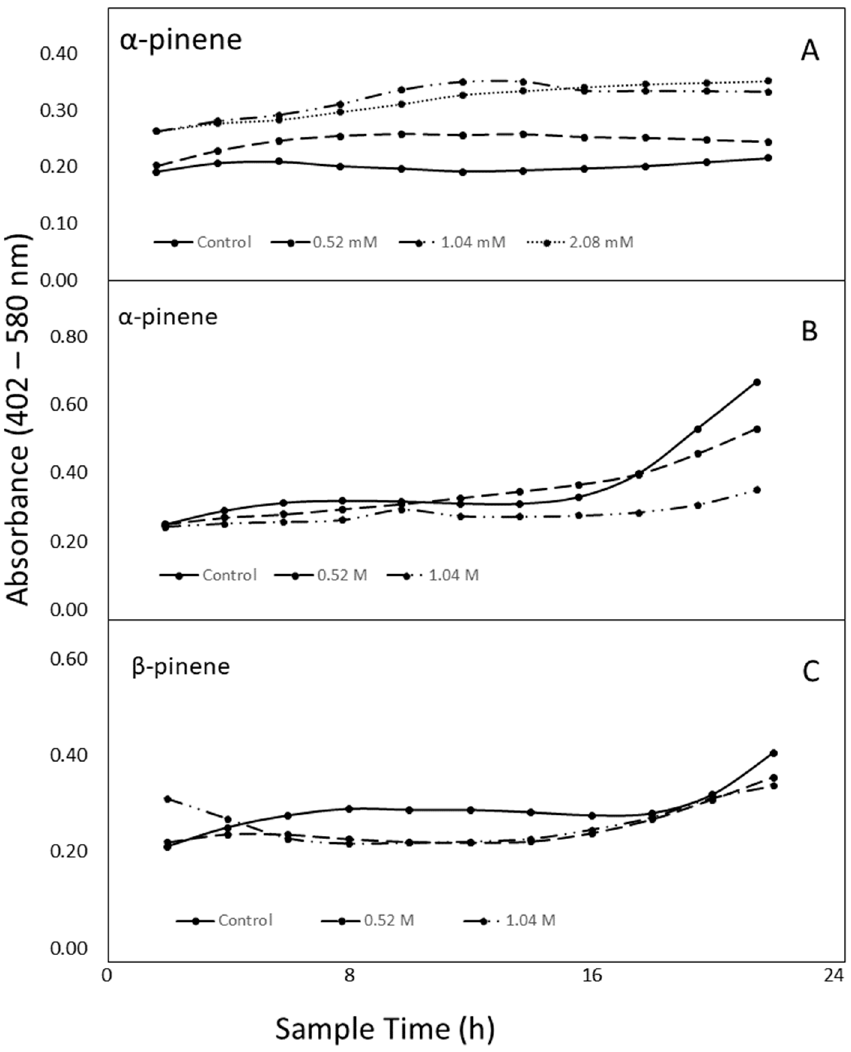
Figure 7. Changes in absorbance of Bacillus cereus cultures exposed to pinenes. ( A ) Concentrations of α -pinene lower than or equal to estimates of α -pinene concentration in Sv resin. ( B ) Concentrations of α -pinene of up to 1000 times greater than estimates of α -pinene concentration in Sv resin. ( C ) Concentrations of β -pinene up to 1000 times greater than estimates of α -pinene concentration in Sv resin. Wide-band filter (402–580) was used to measure turbidity increase associated with growth of bacterial cultures.